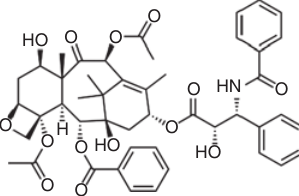
Figure 1: Chemical structure of